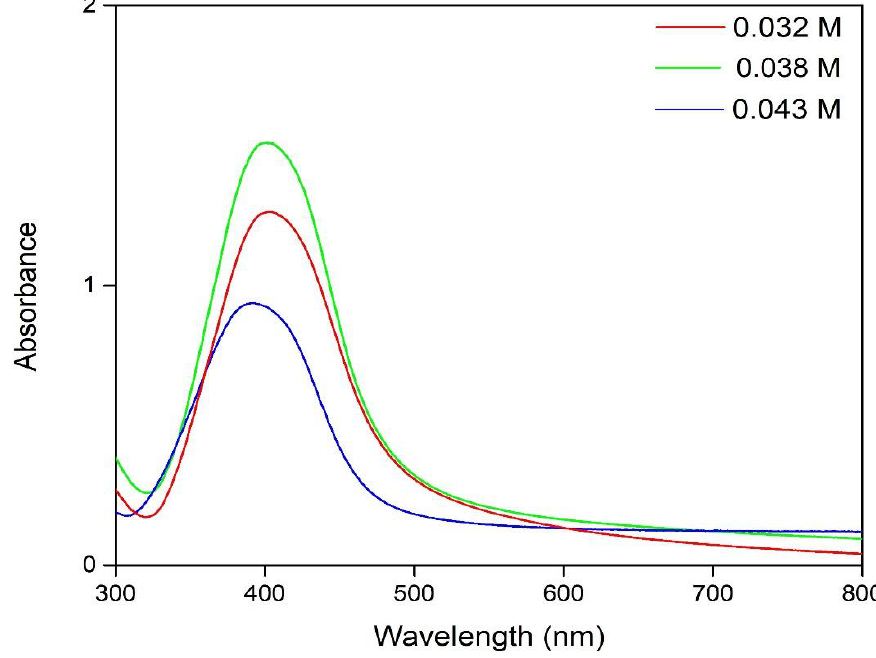
Figure 2. The influence of the concentration of TSC on AgNP synthesis. Figure 1. The influence of the concentration of TSC on AgNP